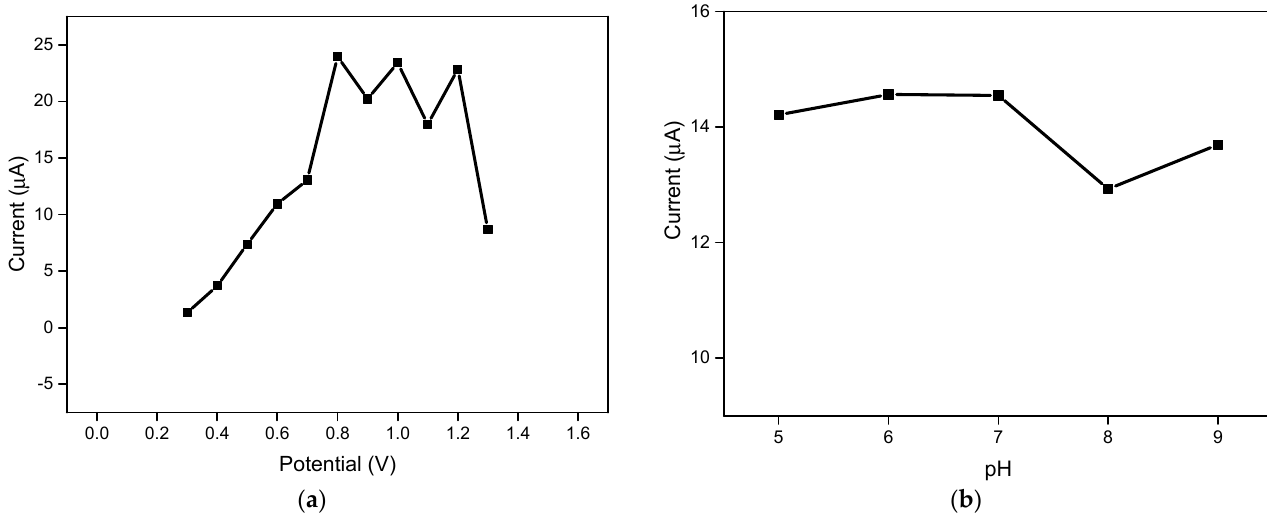
Figure 6. ( a ) Chronoamperometry response at 60 s in different applied potential with 5 mM glucose; and ( b ) Chronoamperometry response at 60 s in different buffer pH with 2 mM glucose.